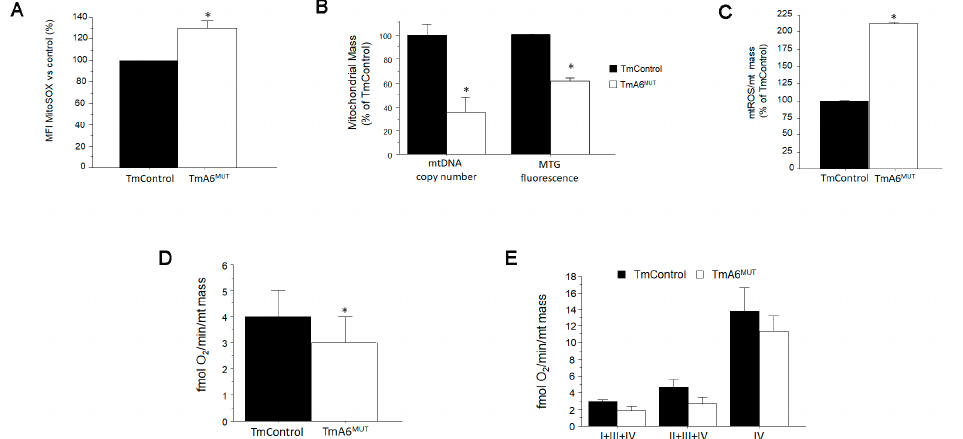
Figure 4. Analysis of mitochondrial ROS (mtROS) production and mitochondrial mass: ( A ) mtROS production in control and mutant cells was analyzed by flow cytometry after staining with MitoSOX TM ( n = 2 for both cell lines, p = 0.0208); ( B ) mitochondrial mass was estimated by two different ways: mtDNA copy number quantification by qPCR (left) and flow cytometry (right) after mitochondria staining with MitoTracker Green TM , a fluorescent probe that specifically stains mito- chondria regardless of ∆Ψ m ( n = 5 for mtDNA copy number quantification in both cell lines, p < 0.001 and n = 2 for mitochondrial mass estimation using MitoTracker Green; p = 0.0002); ( C ) mtROS production per mitochondria. Estimation of mitochondrial superoxide production normalized to mitochondrial mass ( n = 3 in both cases, p = 0.025); ( D ) oxygen consumption (coupled respiration) normalized per mitochondrial mass (n = 9 and 12 for control and mutant respectively, p = 0.046); and ( E ) oxygen consumption of digitonin-permeabilized cells with specific substrates normalized per mitochondrial mass ( n = 2 and 3 for control and mutant respectively and p > 0.05 in all cases). In all cases, the normalization by mitochondrial mass was done using the data from MitoTracker Green TM staining. All values are expressed as mean ± SD of the mean. Asterisks indicate significant differences respect to control cells, tested by ANOVA post-hoc Fisher PLSD ( p < 0.05 or as